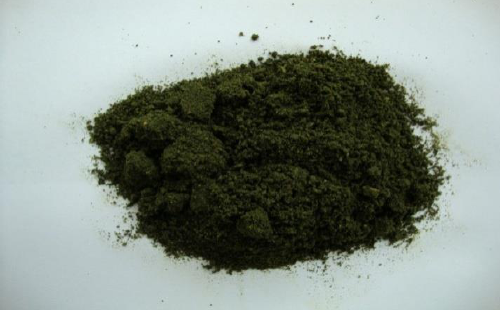
Figure 1. Traditional Nass or Naswar powder